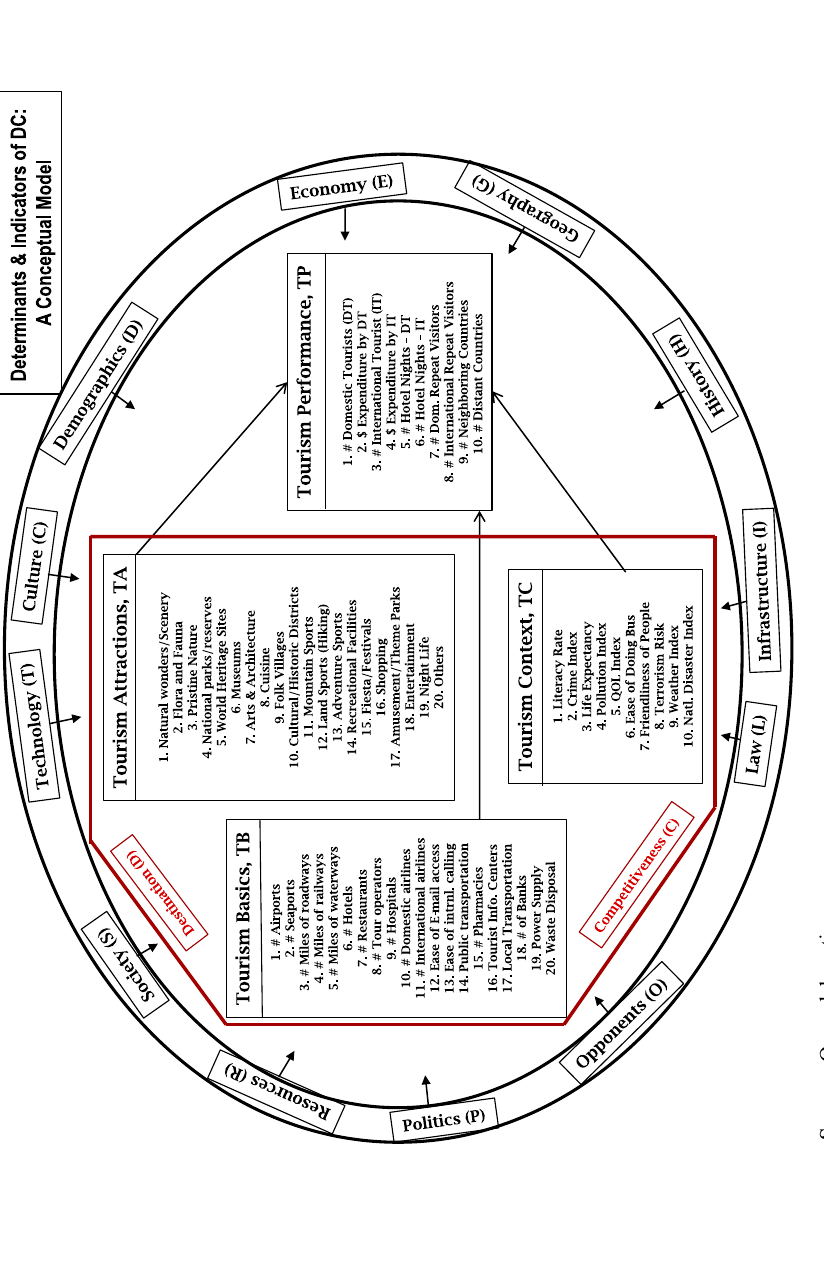
Figure 1. Determinants and indicators of DC: